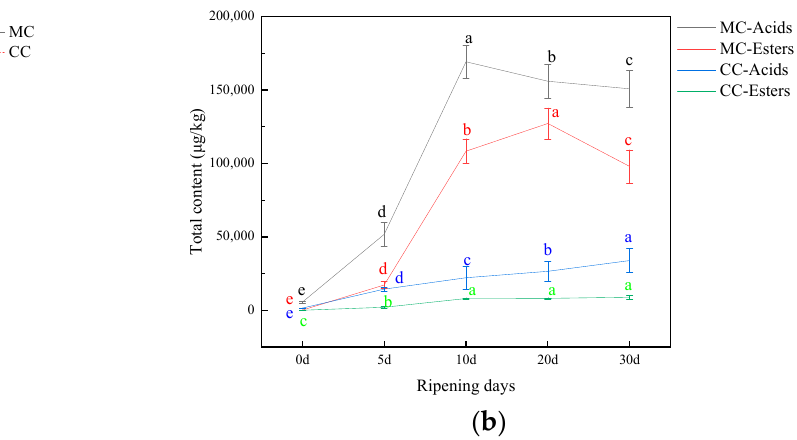
Figure 3. ( a ) The activity of esterases of CC and MC during the 30-day ripening period; ( b ) the con- tent of total acids and total esters of CC and MC during the 30-day ripening period. CC and MC represent cheese samples collected from control cheeses and Monascus -fermented cheeses, respec- tively. (Different letters in the same line correspond to statistically significant differences ( p < 0.05)).